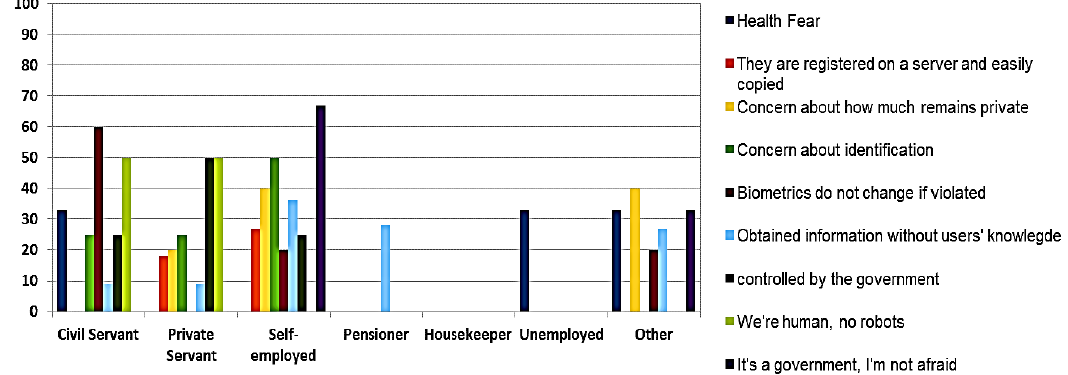
Figure 13. Fears and concerns about BS per father’s occupation.